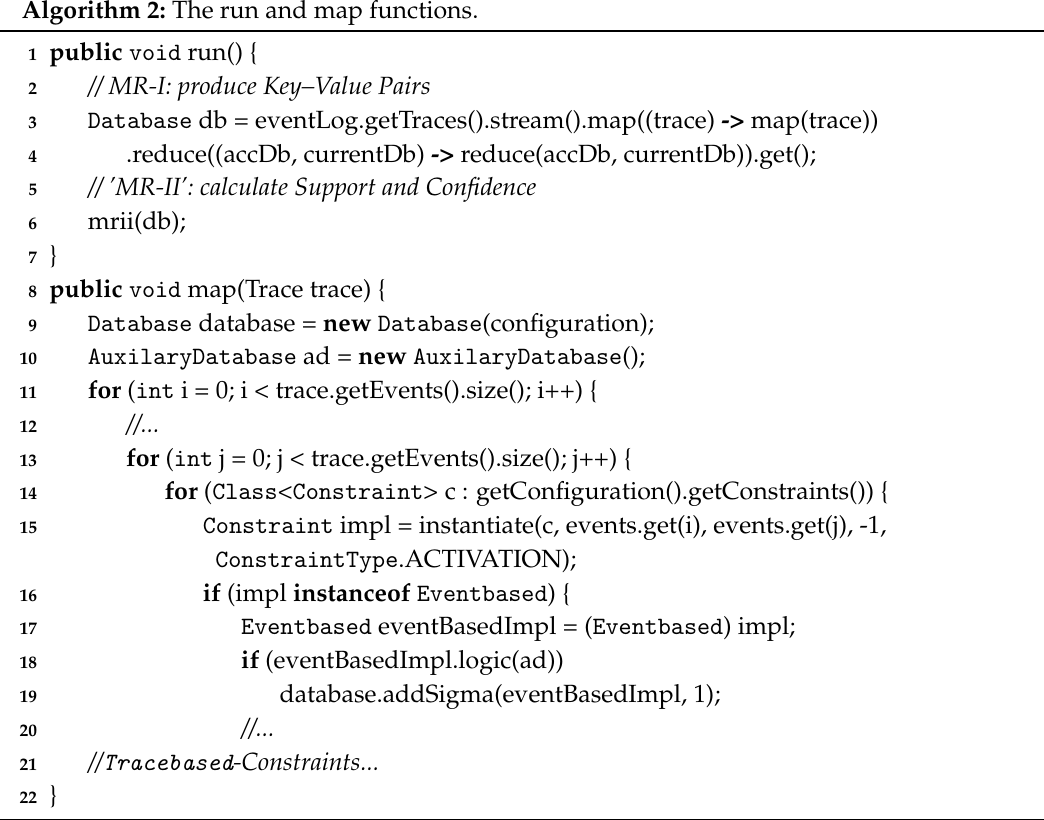
Algorithm 2: The run and map